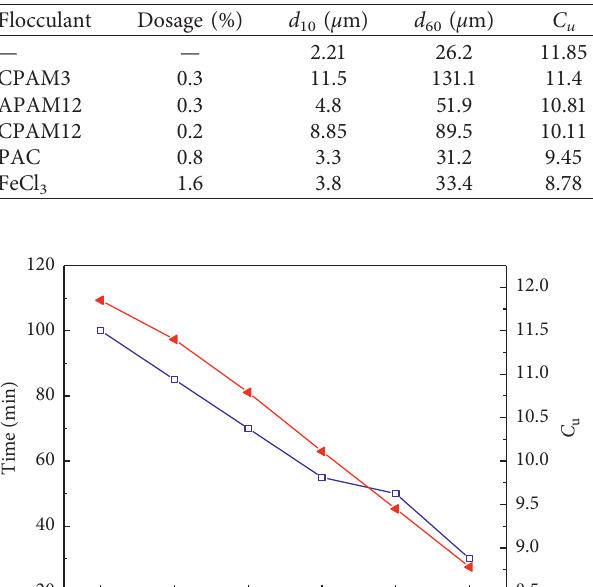
Table 6: Summary of measurements of slurry aggregate size after adding different flocculants.